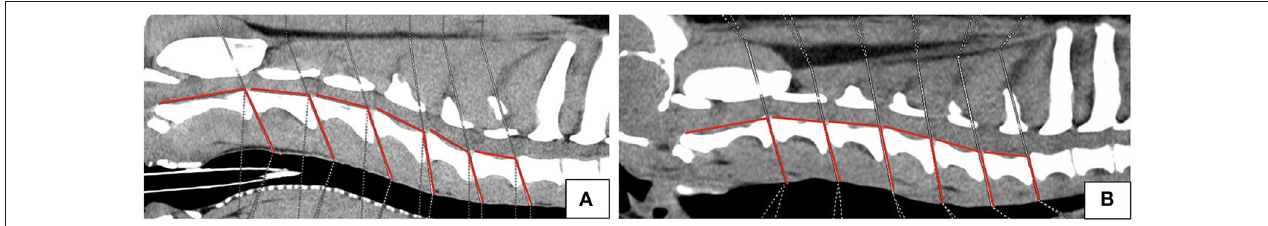
FIGURE 2 | Sagittal plane computed tomographic images of Labrador Retriever (A) and Dachshund (B) showing angle measurements.